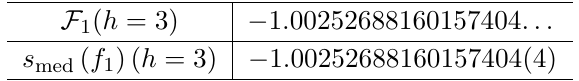
Figure 1 . Comparison between the median resummation of the perturbative series and the exact result. The orange curve is obtained computing the + and − lateral Padé-Borel resummations of the first 41 terms of the perturbative series and taking their average, while the error is estimated from the convergence of the resummation. The black curve (mostly covered by the orange one) is the numerical evaluation of (4.44). The mass m is set to 1, so h = 1 is maximally strong coupling.